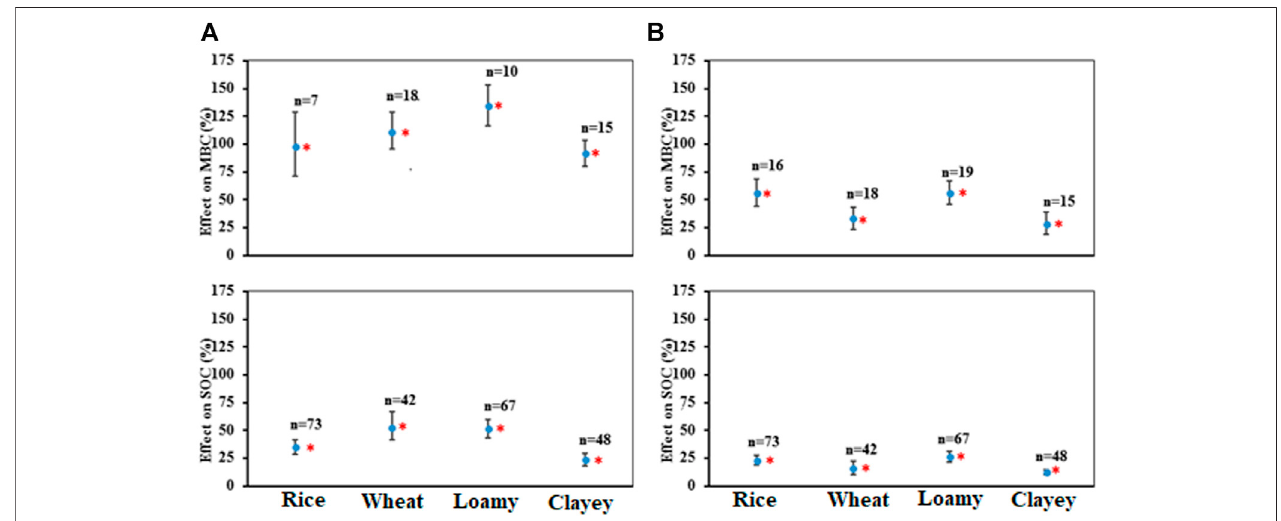
FIGURE 2 | Effect of integrated nutrient management (INM) on microbial biomass carbon (MBC) and soil organic carbon (SOC) with respect to (A) without fertilization/without NPK and (B) recommended dose of fertilizers through chemicals only (100% NPK) in rice and wheat crops as in fl uenced by soil texture: loamy and clayey in Indian soils (*Indicates signi fi cant at p < 0.05).